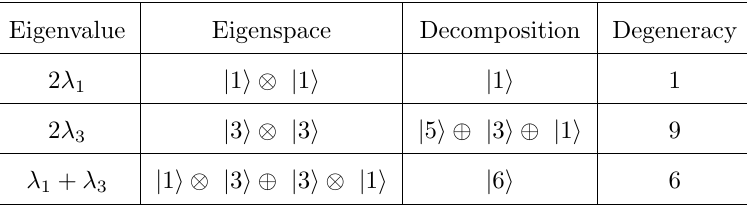
chain for L = 2, in the limit (cid:13) ! 2